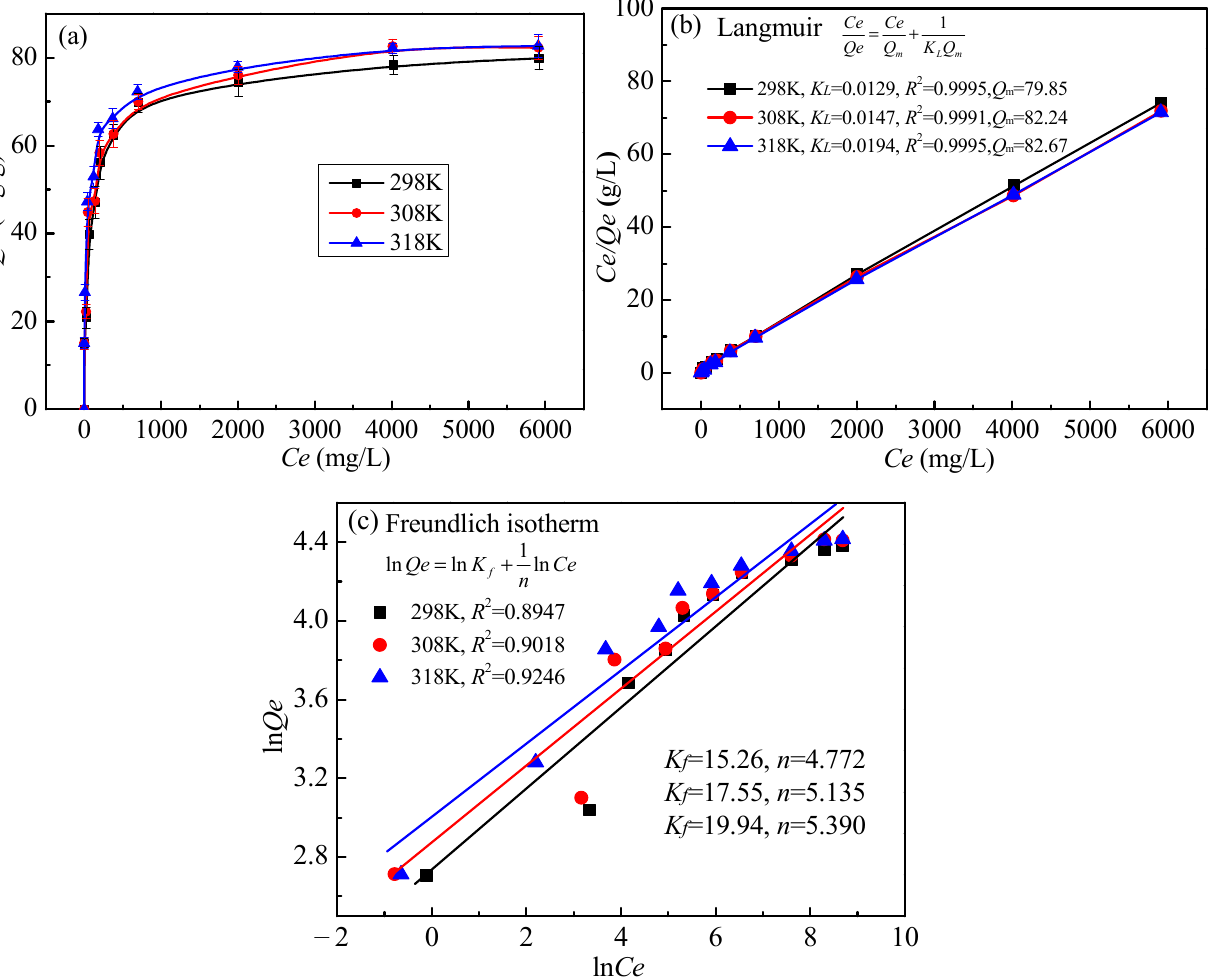
Figure 8. The adsorption isotherms of Pb(II) on the MT-WAO resin: ( a ) the influence of the initial concentration of Pb(II) on the adsorption, ( b ) the fitting of Langmuir model, ( c ) the fitting of Freundlich model. Table 2. The fitting parameters of the adsorption isotherms for the Langmuir and Freundlich mod- els.